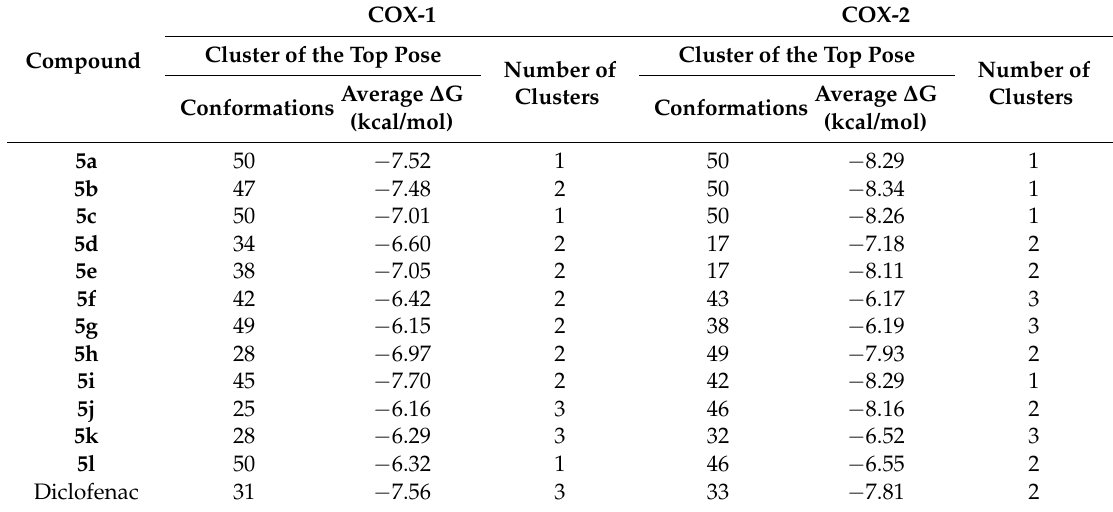
Table 5. Clustering analysis of the resulted poses from the molecular docking study to the COX-1 and COX-2 enzymes.